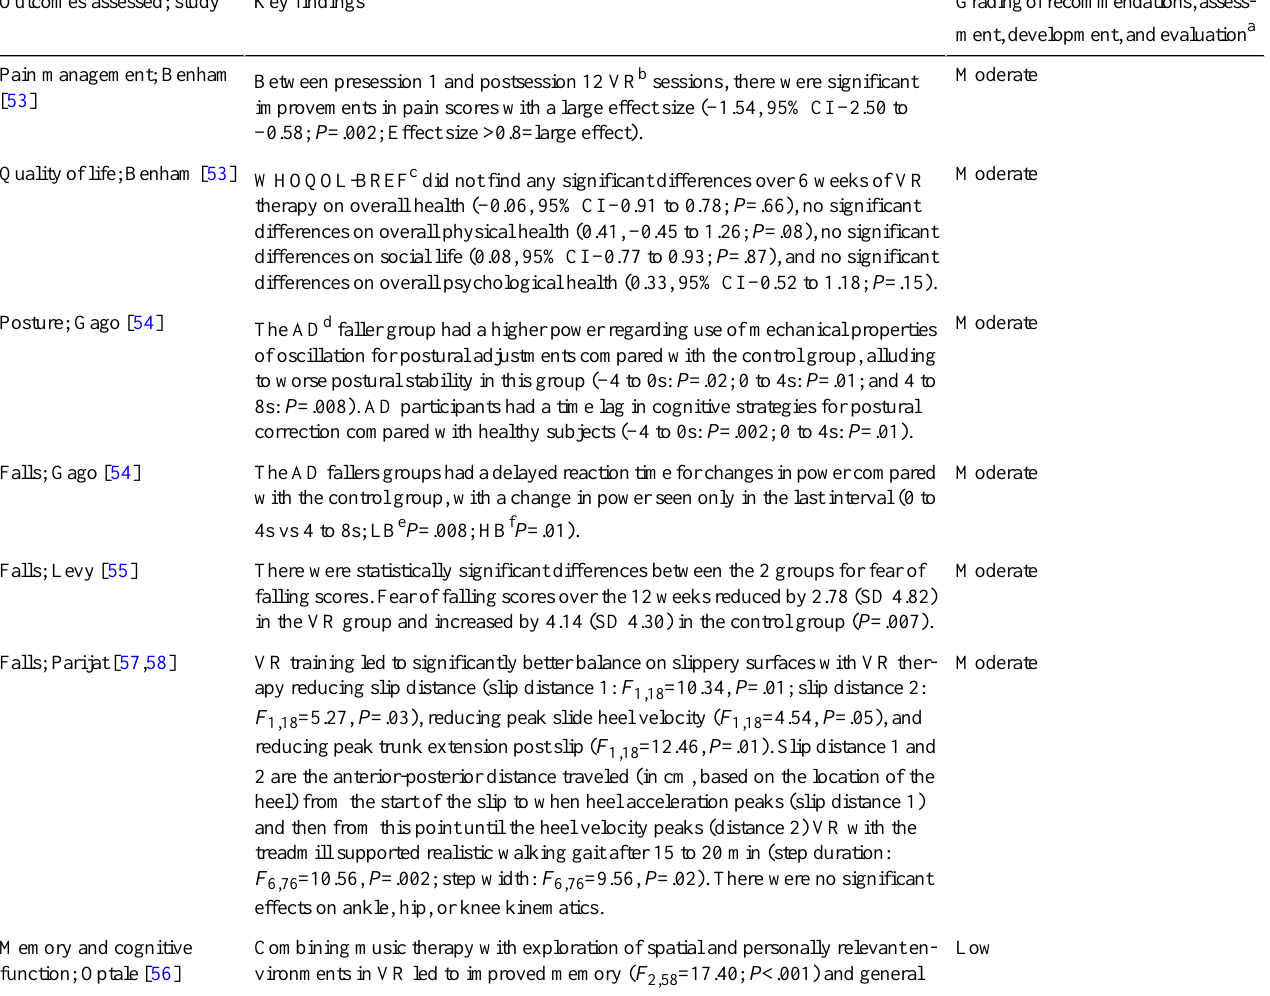
Grading of recommendations, assess- ment, development, and evaluation